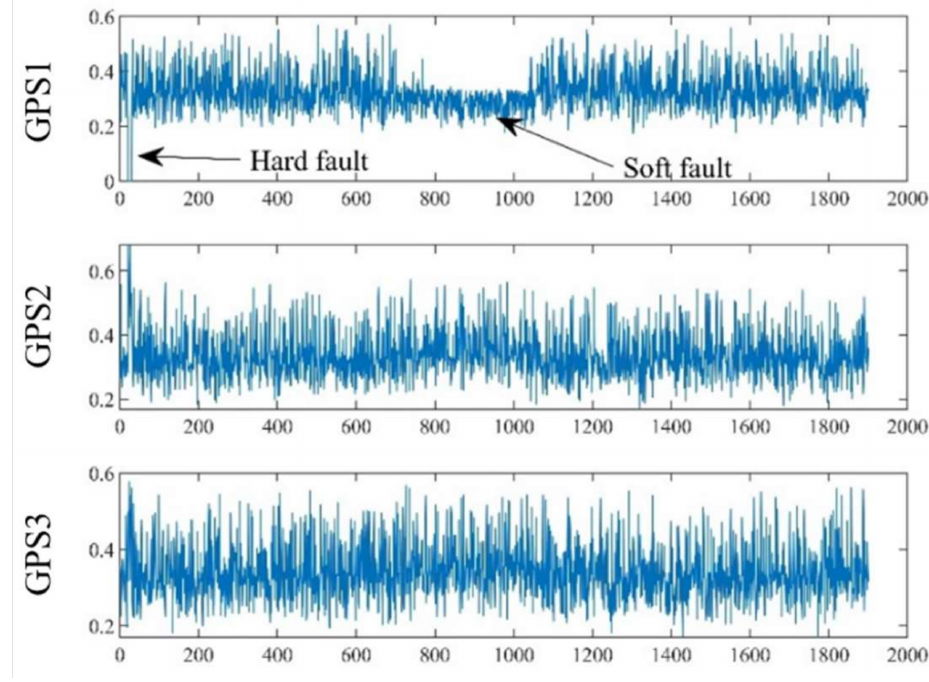
Figure 8. Information weight of